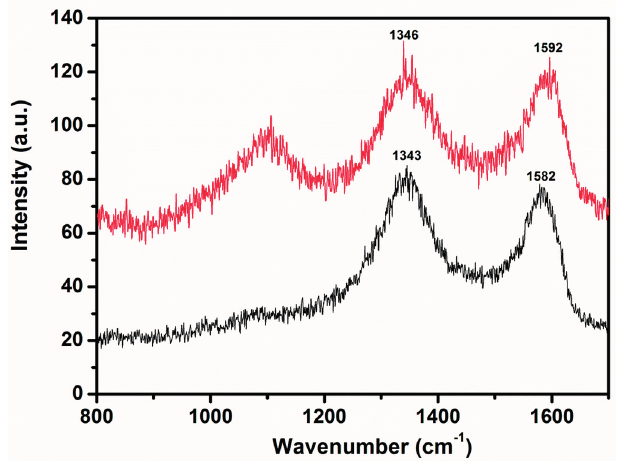
Figure 3. Raman spectra of graphene oxide (GRO, red line) and highly reduced graphene oxide (PE-HRG, black line) using P. glutinosa plant extract